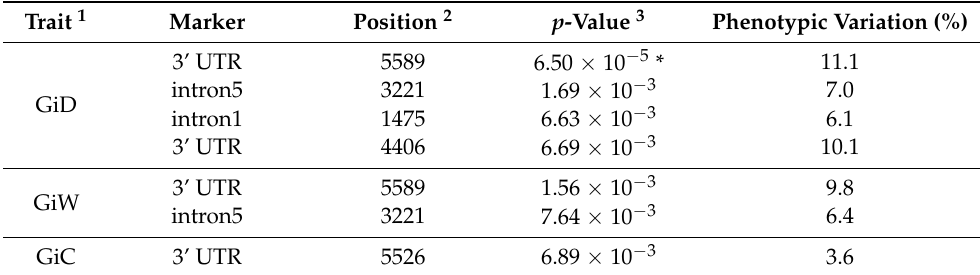
Figure 2. Quantile-quantile plots of estimated − log10 ( p ) from association analysis using MLM model and FarmCPU and three traits: ( A )girth in the dry season (GiD) ( B ) girth in the wet season (GiW) and ( C ) total girth increment (GiC). The black line is the expected line under the null distribution. The blue line represents the observed p values using the MLM model, and the red line using FarmCPU. Table 3. Markers and trait association mapping from FarmCPU model.